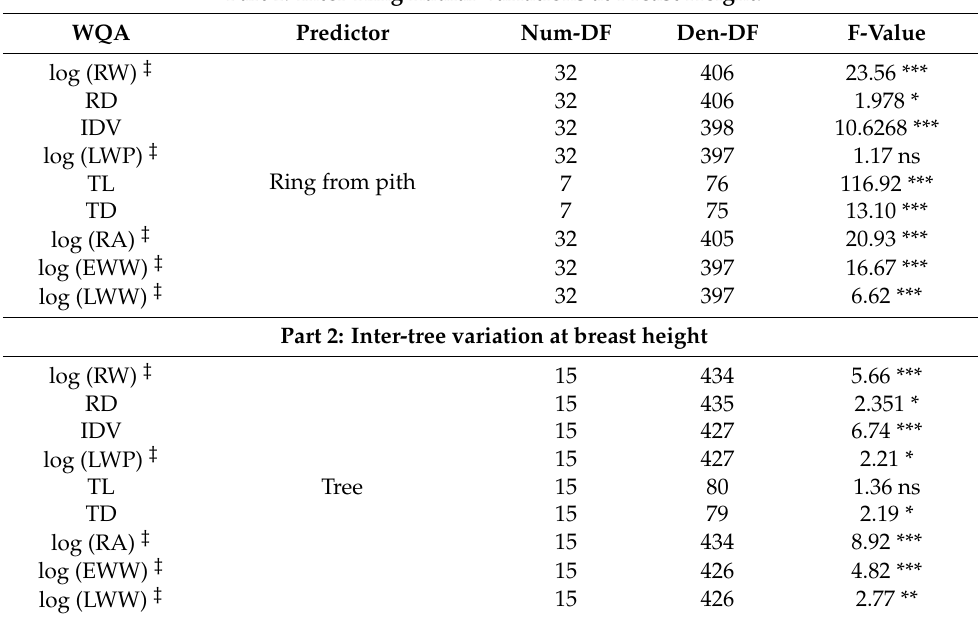
Table 2. Analyses of variance. Part 1: Inter-Ring Radial Variations at Breast